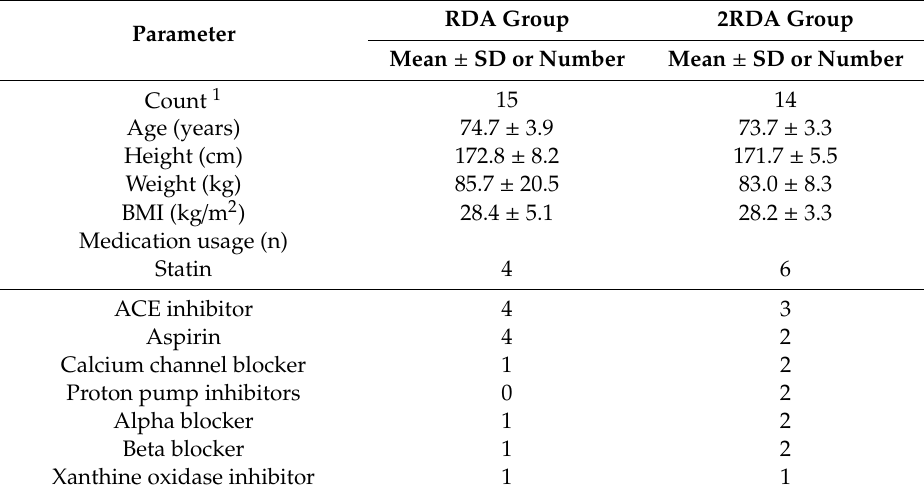
Table 1. Participant characteristics